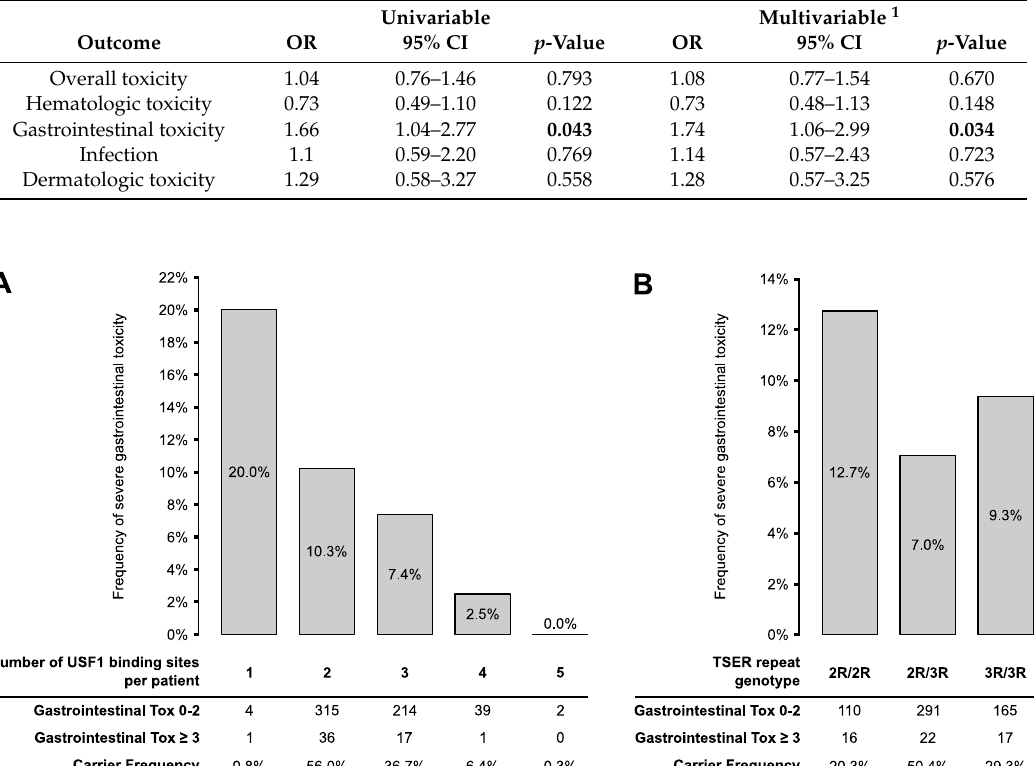
Figure 3. Frequency of severe gastrointestinal toxicity according to number of USF1-binding sites and TSER-repeat genotypes. Gastrointestinal toxicity frequencies were stratified according to ( A ) the number of USF1-binding sites in the full cohort of 629 patients and ( B ) TSER-repeat genotype in a subcohort of 607 patients carrying only 2R or 3R polymorphisms.